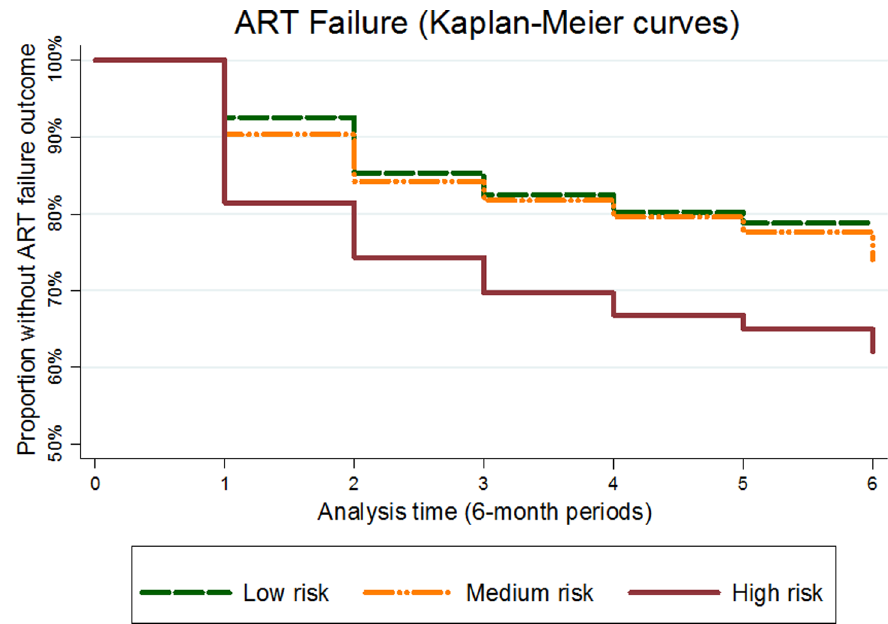
Figure 3. Kaplan Meier Curves for ART Failure by Risk Category (42-month outcome). Log rank test: p , 0.001; CI: Confidence interval. doi:10.1371/journal.pone.0112261.g003 PLOS ONE |